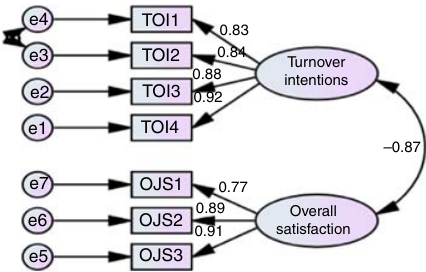
Figure 4. Results of confirmatory factor analysis (CFA) for overall job satisfaction and turnover